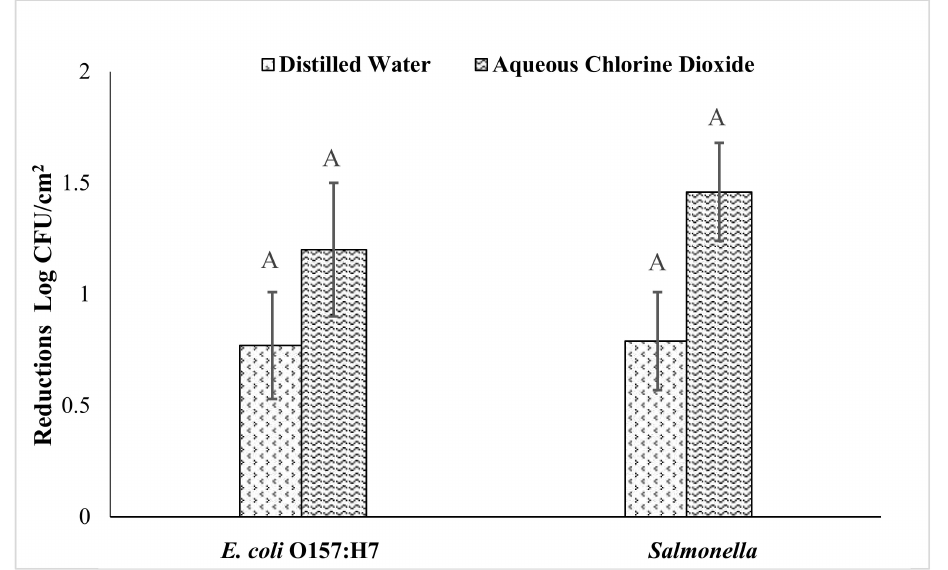
Figure 5. E ff ects of aqueous ClO 2 and water treatment on the reduction of E. coli O157: H7 and Salmonella on freshly harvested sweet potatoes. Reduction of E. coli O157: H7 and Salmonella on freshly harvested sweet potatoes after aqueous ClO 2 treatment (5 ppm) and water treatment for 10 min at 22 ± 1 ◦ C. The data are presented as average counts ± standard error. Same uppercase letters on the top of the diagrams indicate no significant di ff erence ( p < 0.05) in between the